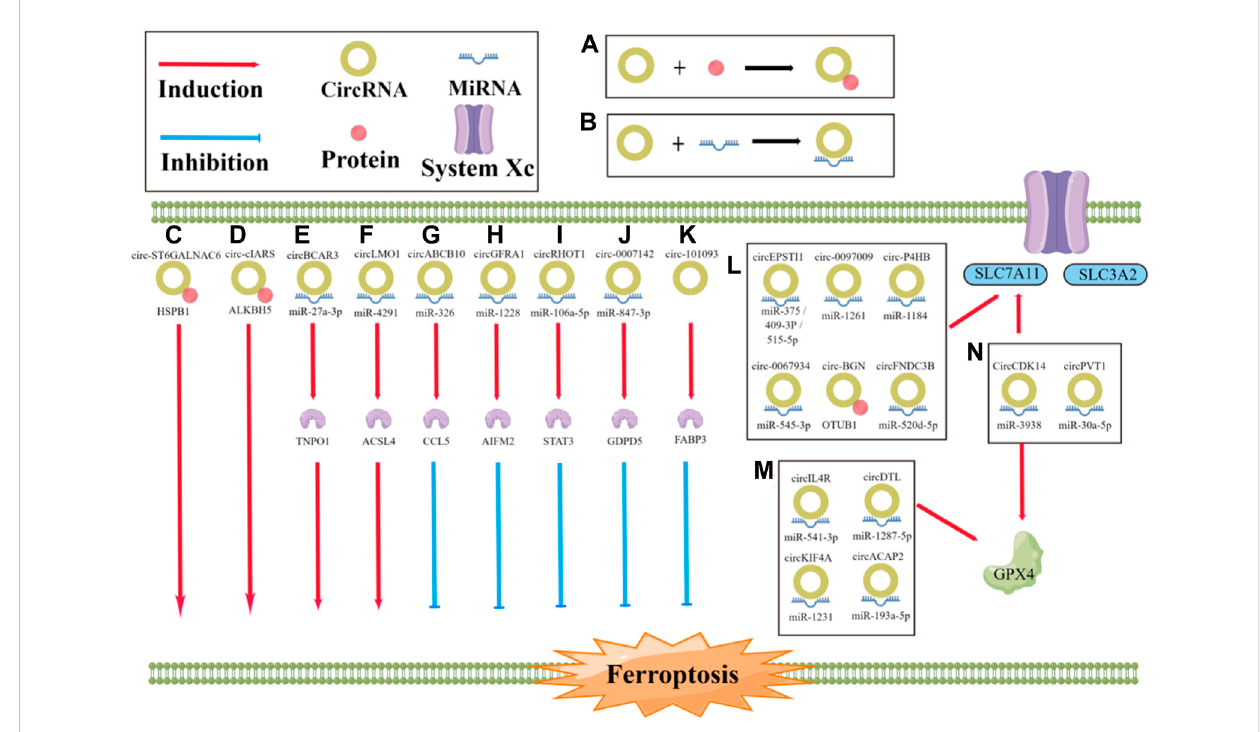
FIGURE 3 RoleofcircRNAintheregulationofferroptosis. (A,B) Theprogressionofferroptosiscanbein fl uencedbycircRNAs,eitherbysponging miRNAorby directly binding to proteins, which can promote or inhibit the process; (C) circST6GALNAC6 directly binding to HSPB1 to promote the ferroptosis; (D) circ-cIARS directly binding to ALKBH5 to promote the ferroptosis; (E) circBCAR3 sponging miR-27a-3p to promote the ferroptosis; (F) CircLMO1 sponging miR-4291 to promote the ferroptosis; (G) circABCB10 sponging miR-326 to inhibit the ferroptosis; (H) circGFRA1 sponging miR-1228 to inhibit the ferroptosis; (I) circRHOT1 sponging miR-106a-5p to inhibit the ferroptosis; (J) circ0007142 sponging miR-847-3p to inhibit the ferroptosis; (K) circRNA-101093 directly binding to FABP3 to inhibit the ferroptosis; (L, M) CircRNAs sponging miRNA or directly binding to proteins to regulate the